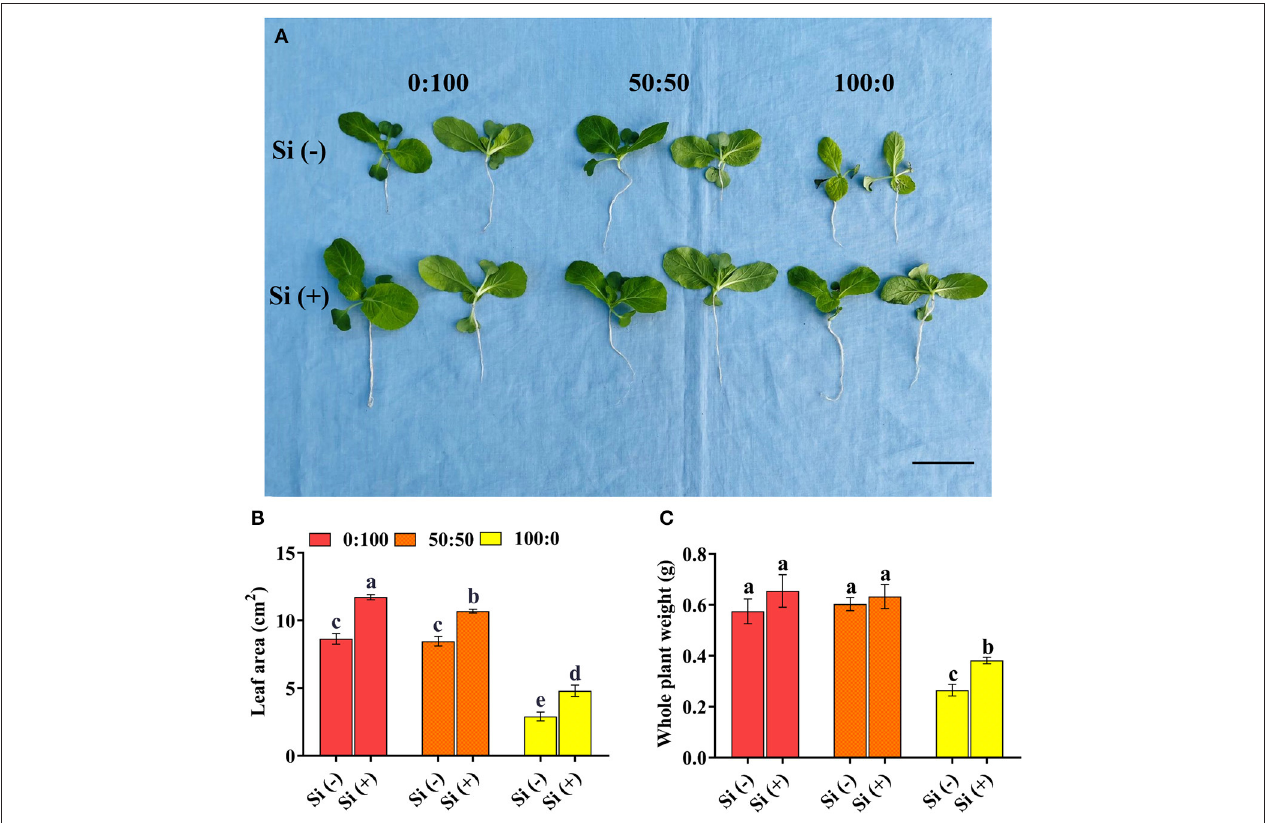
FIGURE 1 | (A) Cabbage growth status regarding (B) leaf area and (C) whole plant weight as affected by the three NH + 4 :NO − 3 ratios and Si applications. Plant exposure to the same treatment is presented by a plant pair with similar growth. Data are the means plus standard errors ( n = 6 independent replicates); different lowercases denote the significant difference, which was determined by Duncan’s multiple range test at p = 0.05. Scale bar in (A) refers to